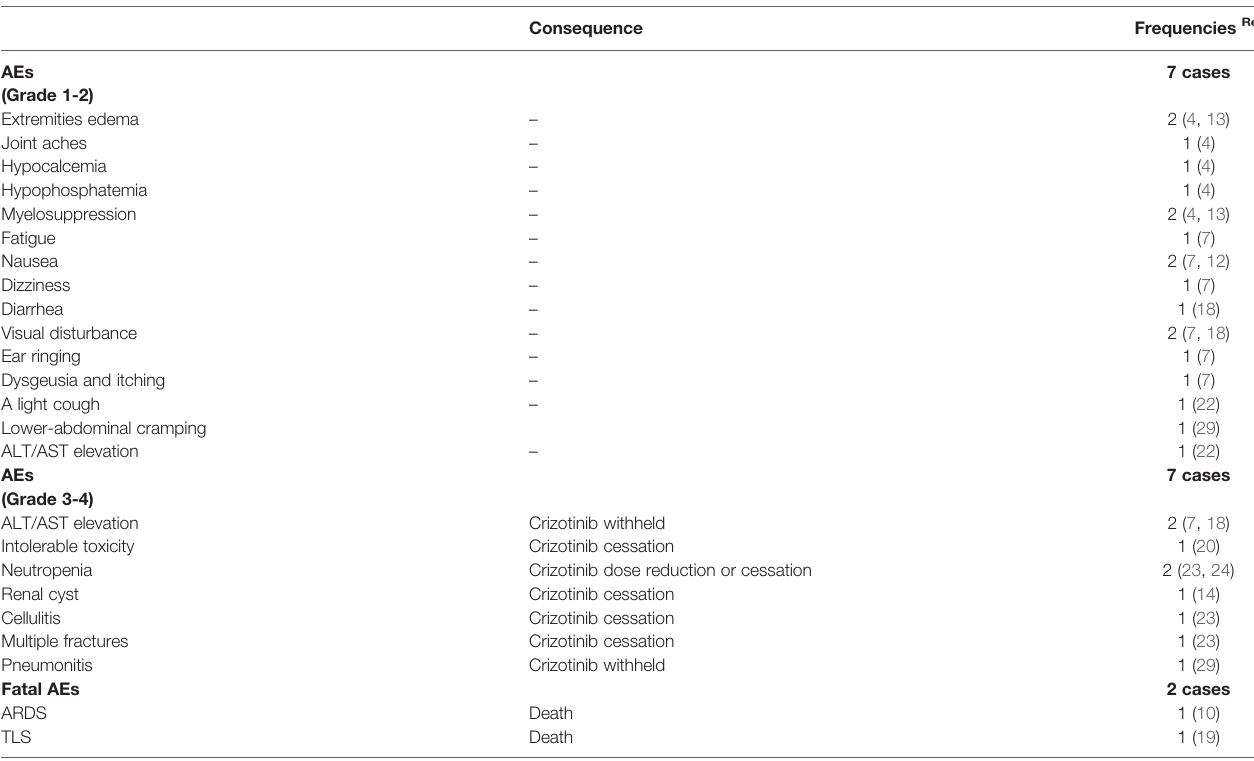
TABLE 4 | Crizotinib-related AEs in ALK-fusion sarcomatous